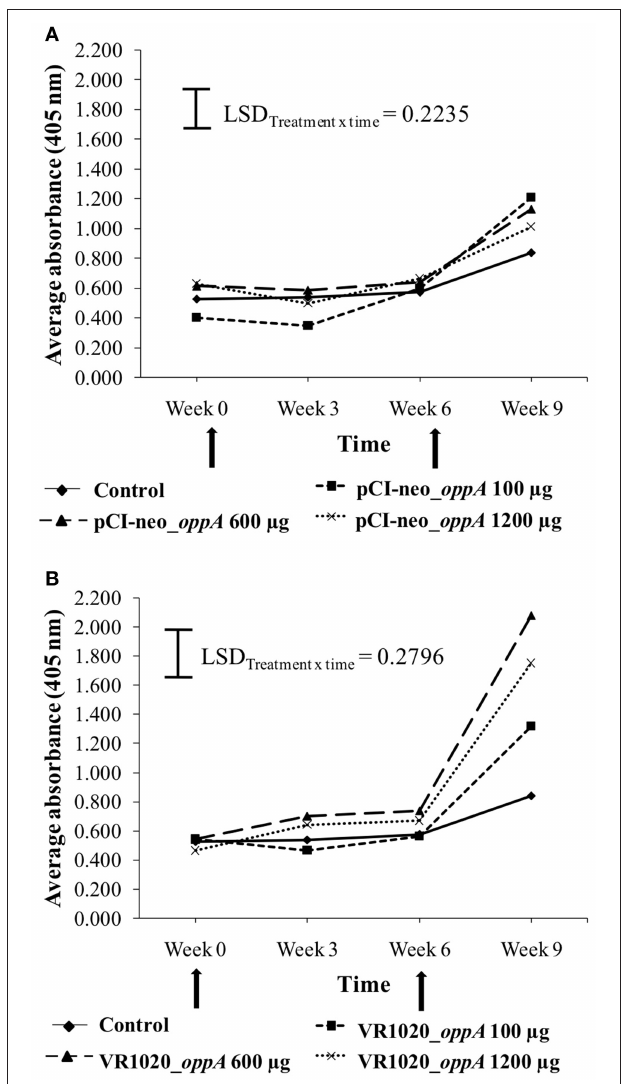
FIGURE 2 | Anti-OppA antibody response elicited in response to vaccination with different doses of the pCI-neo_ oppA (A) and VR1020_ oppA (B) vaccines. The black arrows indicate the time points at which the ostriches were vaccinated. The control group did not receive any vaccine.